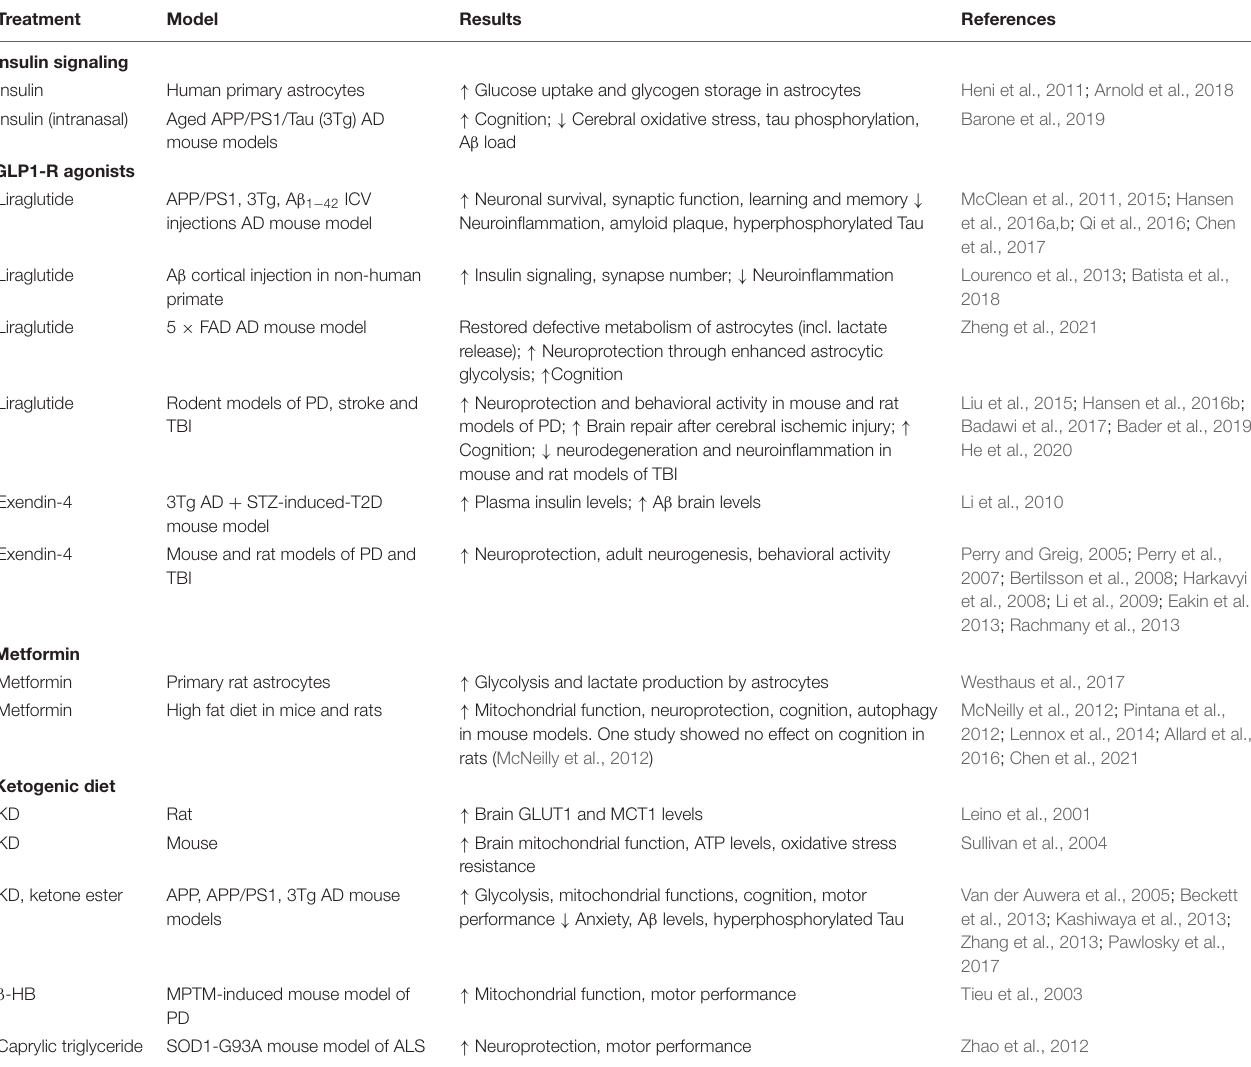
TABLE 1 | Preclinical evidence of compounds targeting brain energy